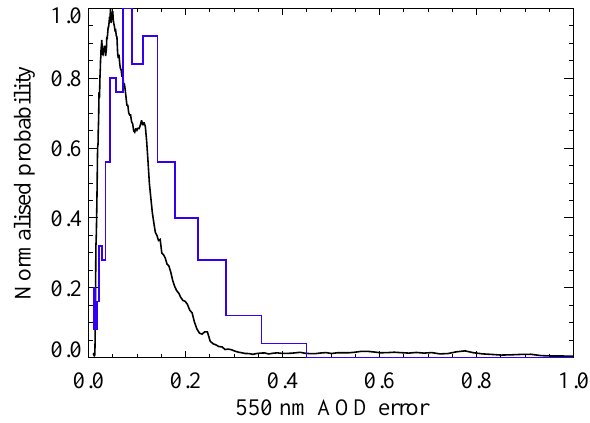
Fig. 4. Normalised histograms of the retrieved error in GRAPE AODs over the ocean (black line) and the discrepancy between GRAPE and AERONET AODs (blue line).